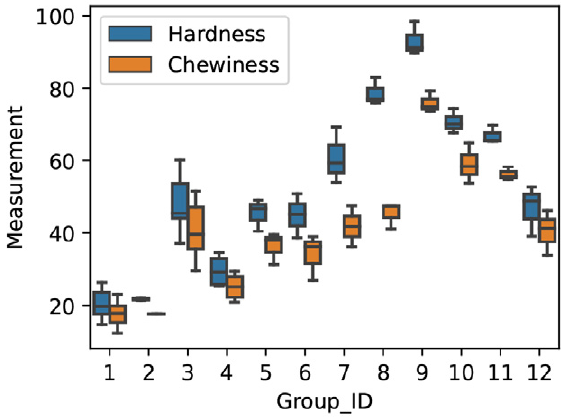
Figure 4. Distribution of Hardness and Chewiness across meat analogs.